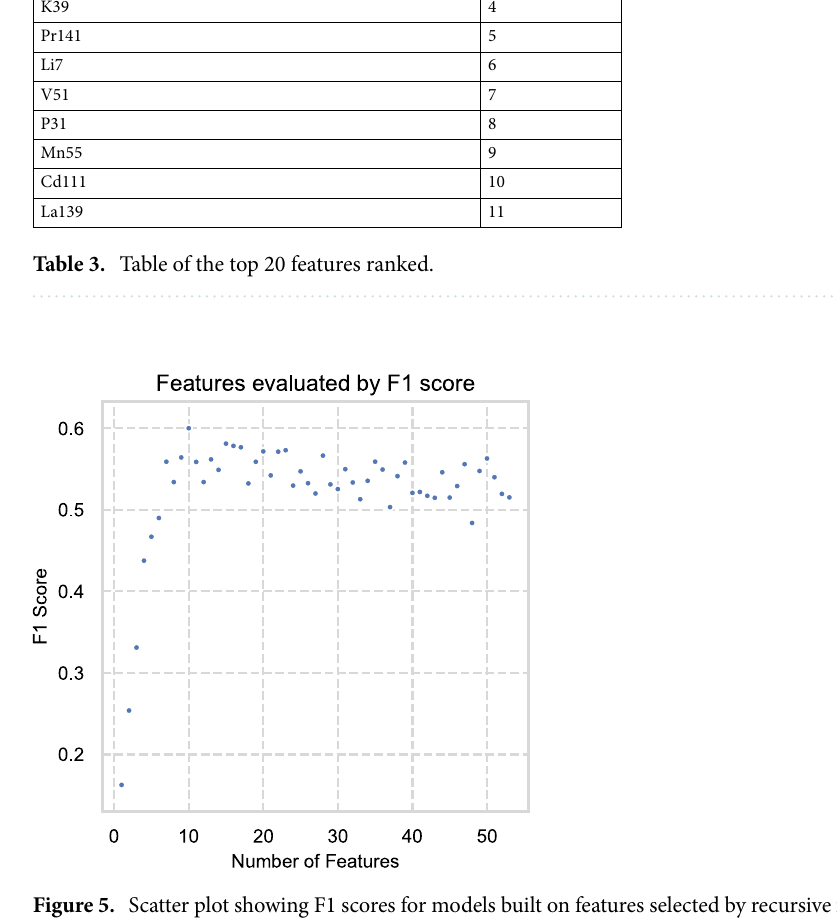
Figure 5. Scatter plot showing F1 scores for models built on features selected by recursive feature elimination.